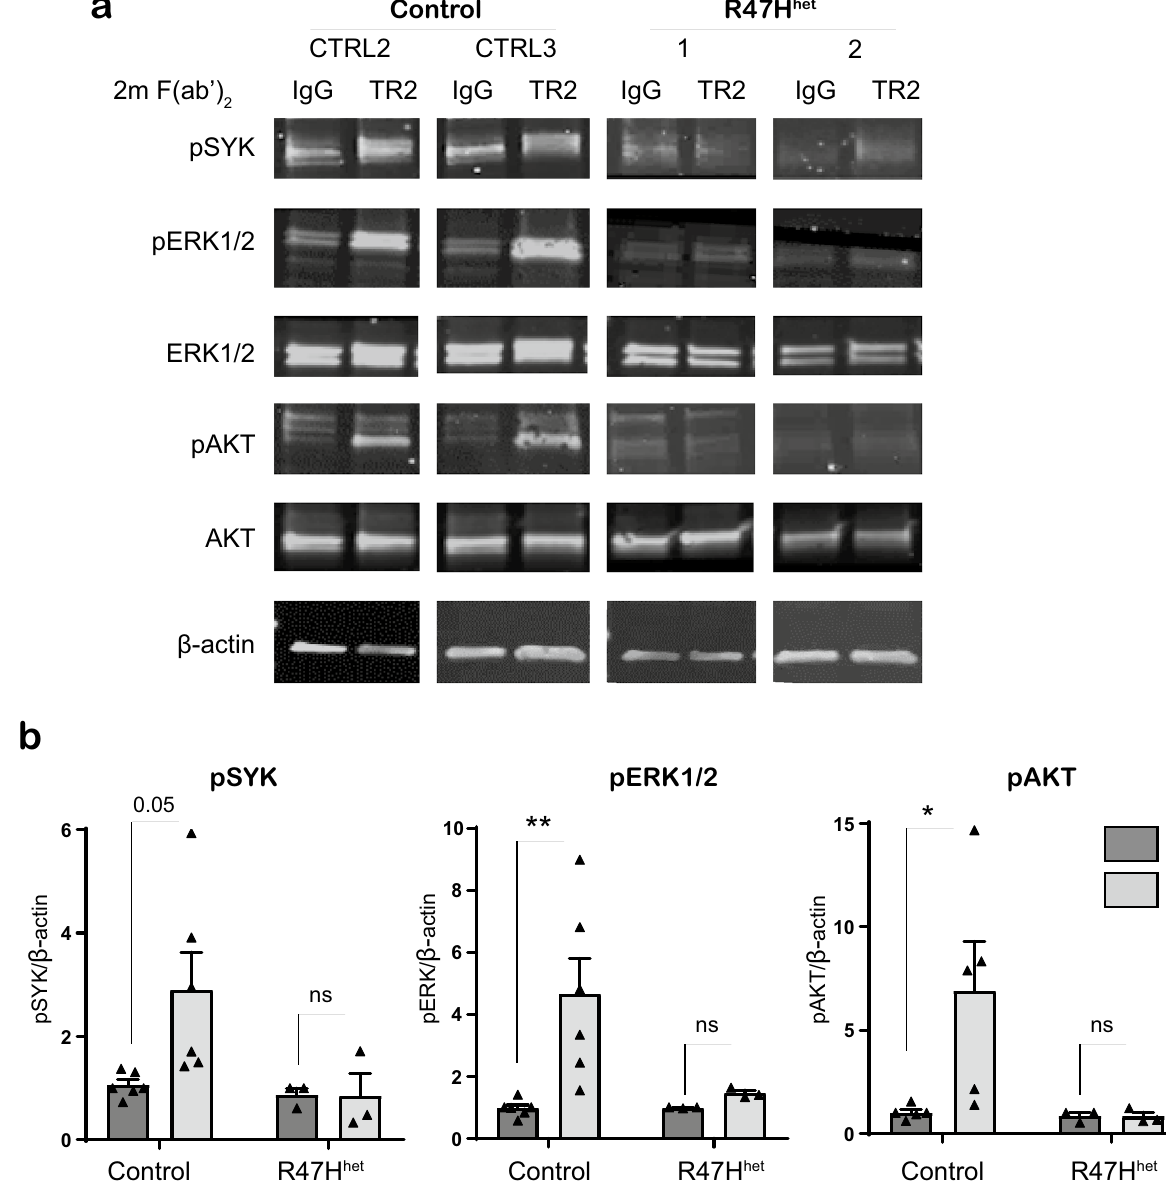
Figure 1. ( a )Western blot analysis of signalling pathways in iPS-derived myeloid progenitor cells following TREM2 activation with TREM2 antibody crosslinking, or IgG control, in control and TREM2 R47H het patient lines. Full length blots are presented in Supplementary Fig. 4. ( b ) Quantification of pSYK, pERK1/2 and pAKT protein normalised to beta-actin; data are mean ± SEM, n = 3–6 cell lines from 3 individual